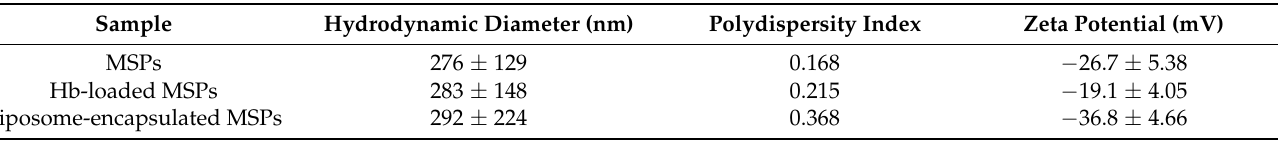
Table 2. Mean hydrodynamic diameters for MSPs, Hb-loaded MSPs, and liposome-encapsulated MSPs (in 1 mM phosphate buffer, pH 7.4), and their Zeta